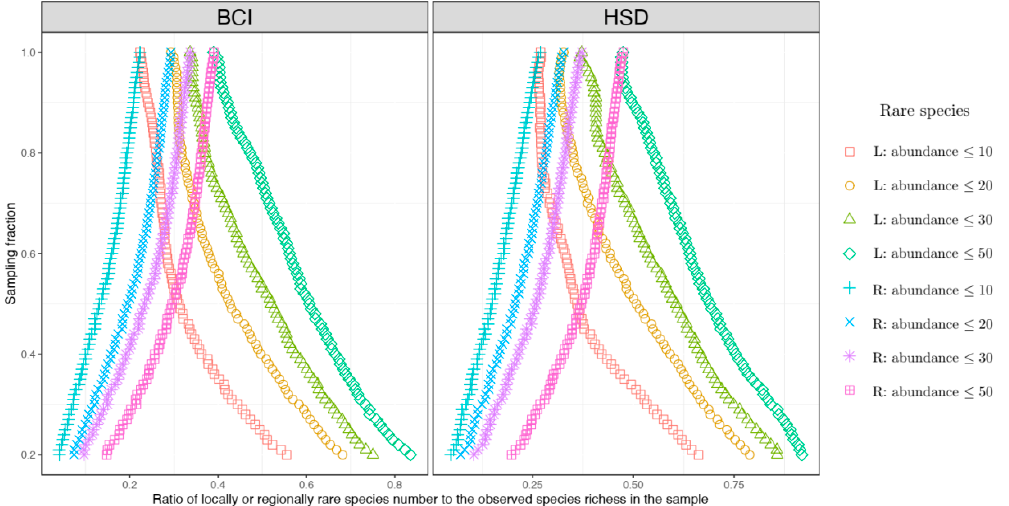
Figure 5. Changing patterns of the ratios between locally rare species and regionally rare species numbers versus the total number of species found in the sampling quadrat with varying grain size (i.e., sampling fraction). “L: abundance” represents the abundance of locally rare species while “R: abundance” is the abundance of regionally rare species.